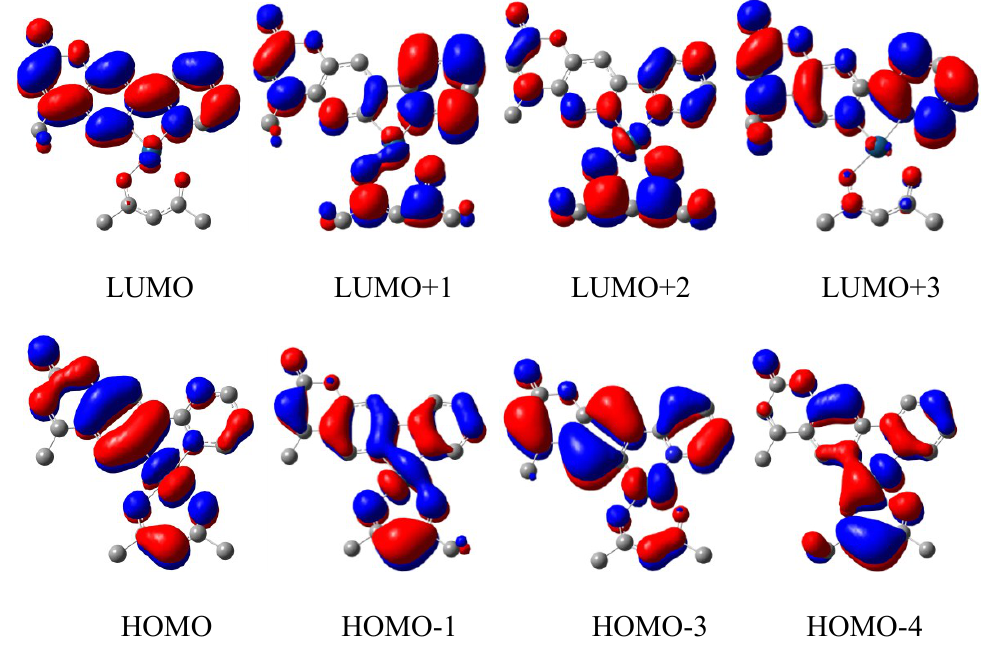
Figure 7. Selected molecular orbitals of complex 2 in the FMO